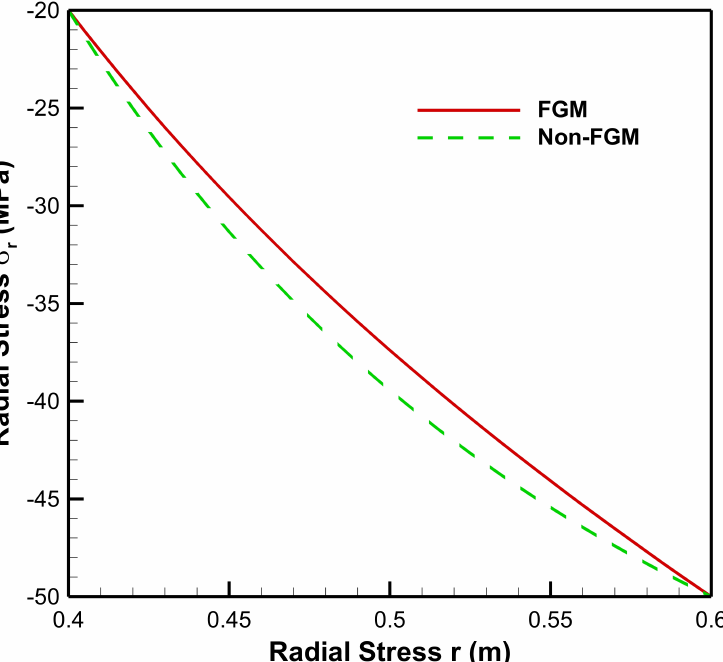
Figure 11. Radial Stress along the radius of the cylinder under internal pressure, P a = 20 MPa and external pressure, P b = 50 MPa.